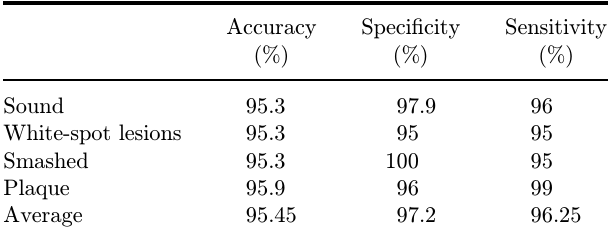
Table 1. Accuracy, sensitivity, speci¯city, and positive pre- dictive value of four dental